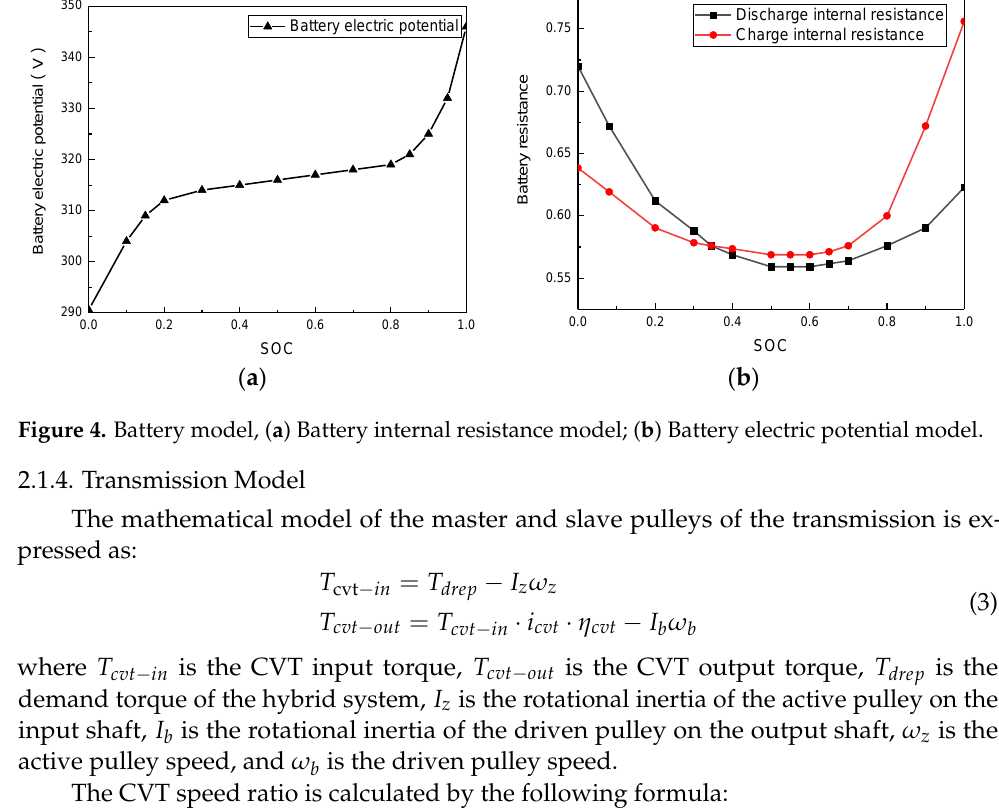
Figure 4. Battery model, ( a ) Battery internal resistance model; ( b ) Battery electric potential model.